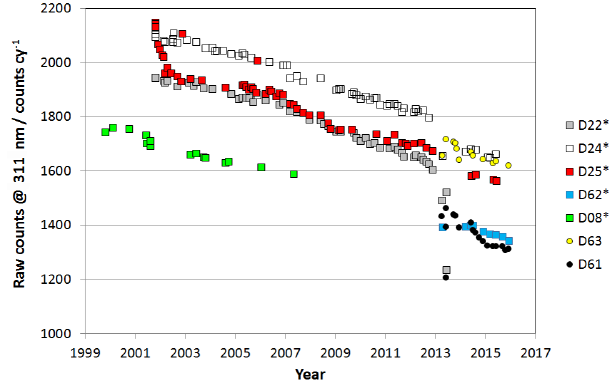
Figure 2. Time series of the raw counts (in units counts per cycle) at 311nm recorded by Brewer #037 spectrophotometer in measure- ments of a selection of 1000W lamps. The lamps marked with an asterisk are primary standard lamps regularly recalibrated in VTT MIKES